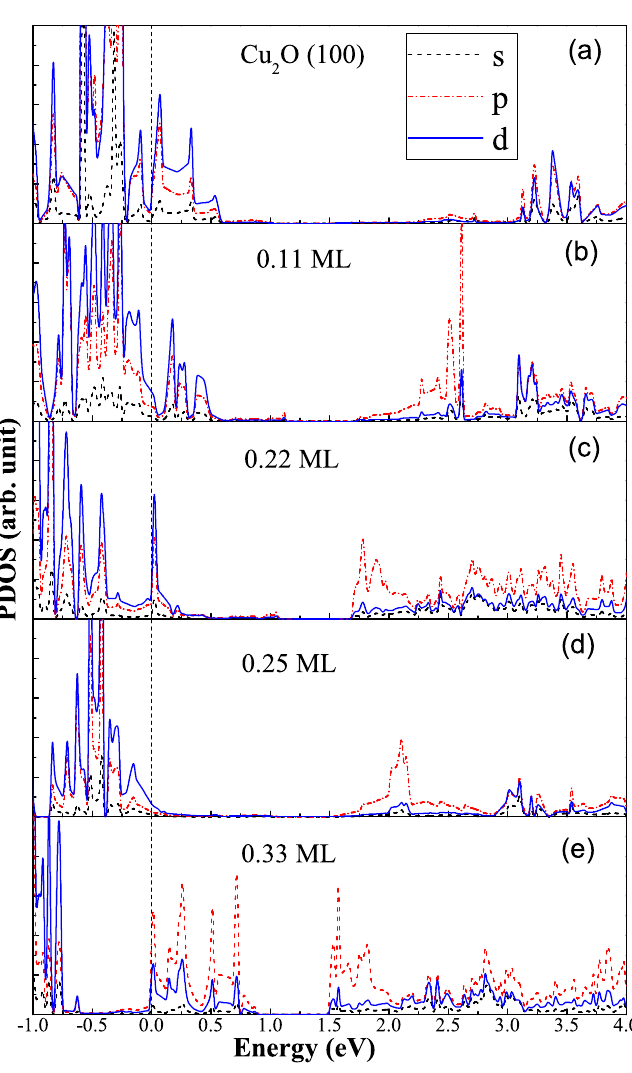
Figure 4. The PDOS of clean Cu 2 O(100) surface and Bi adsorbed Cu 2 O(100) surface. The vertical dashed lines at energy zero indicate the Fermi levels.